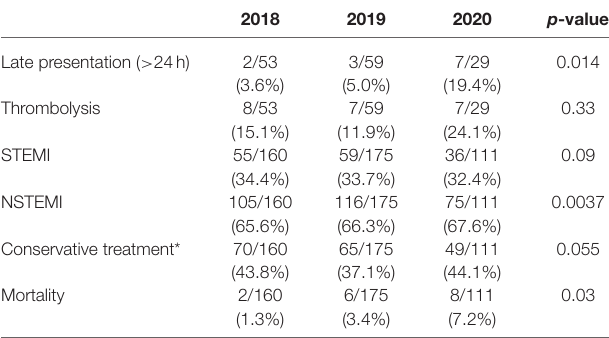
TABLE 2 | Clinical events and outcomes in patients with ACS.